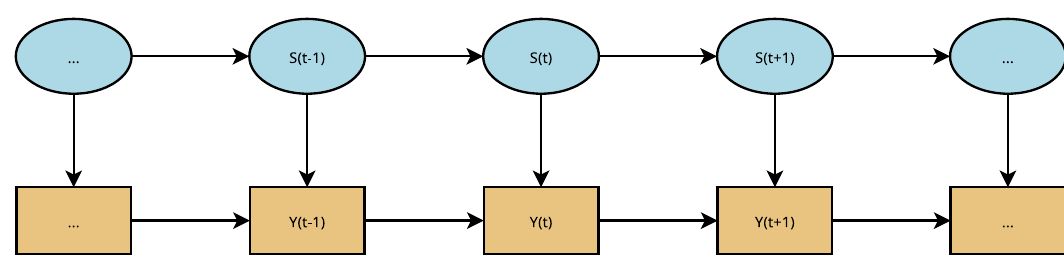
Fig 6. Symbolic representation of Hidden Markov Model